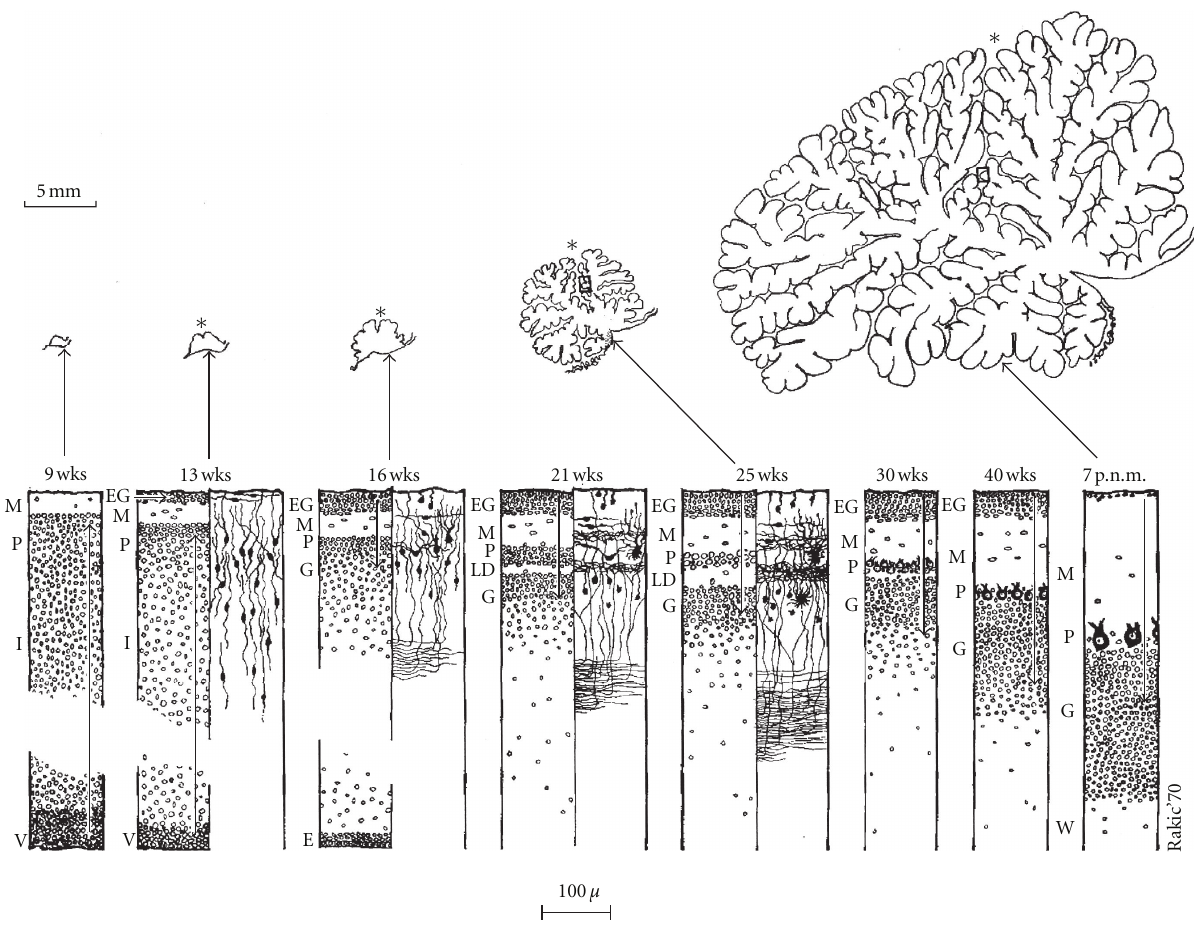
Figure 3: Summary of the main morphogenetic and histogenetic events during development of the human cerebellum from the ninth gestational week (wks) to the seventh postnatal month (p.n.m.) shown in sagittal plane at the level of the primary fissure. E: ependyma, EG: external granular layer, G: Granular layer, I: intermediate layer, L: laminar dissecans, M: molecular layer, P: Purkinje cell layer, V: ventricular zone. W: white matter. The 5mm scale in the upper corner of the figure show the dramatic increase of the cerebellum primordium especially from the beginning of foliation to 16 wks to 7 pnm. Source: from Brain Res 1973